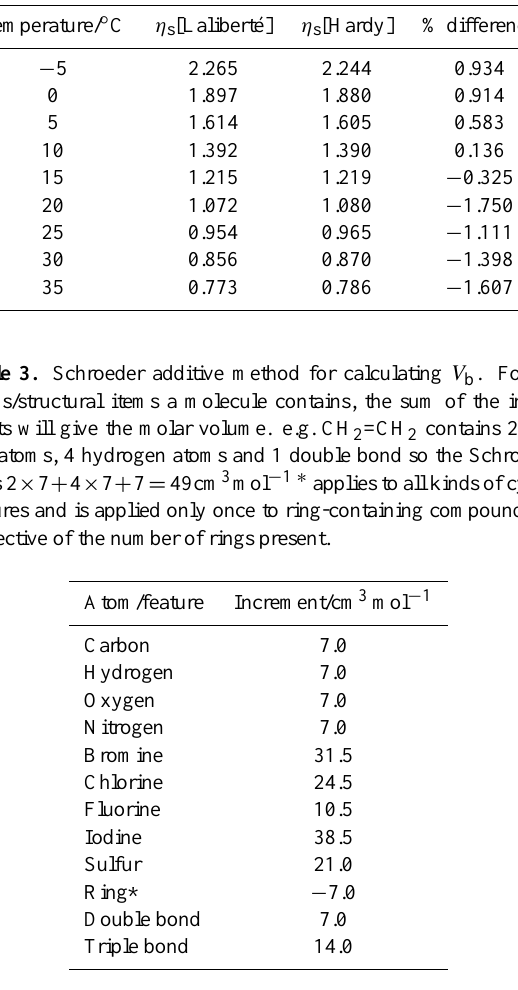
Table 2. Comparison of the Lalibert´e (2007a,b) method for cal- culating the dynamic viscosity of multiple-solute solutions applied to seawater at S = 35 with the experimentally-derived method of R. C. Hardy (ITTC, 2006) (only valid at S = 35). All viscosities in kgm − 1 s − 1 .